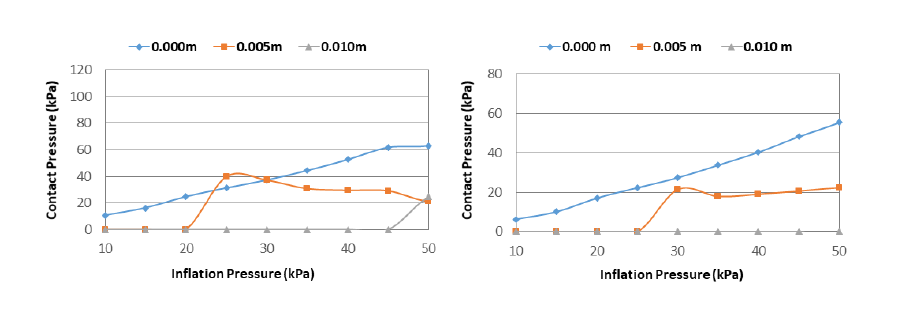
Figure 13. Experimental characterization of soft actuators. ( a ) Experimental measurement of the forward displacement as a function of the inflation pressure. ( b ) Measurement of the contact force as a function of the inflation pressure. ( c ) Relationship between the contact area and the inflation pressure. ( d ) Relationship between the contact pressure in the middle of the soft actuator and the inflation pressure. Graphic legends show the distance between the soft actuator and the object.